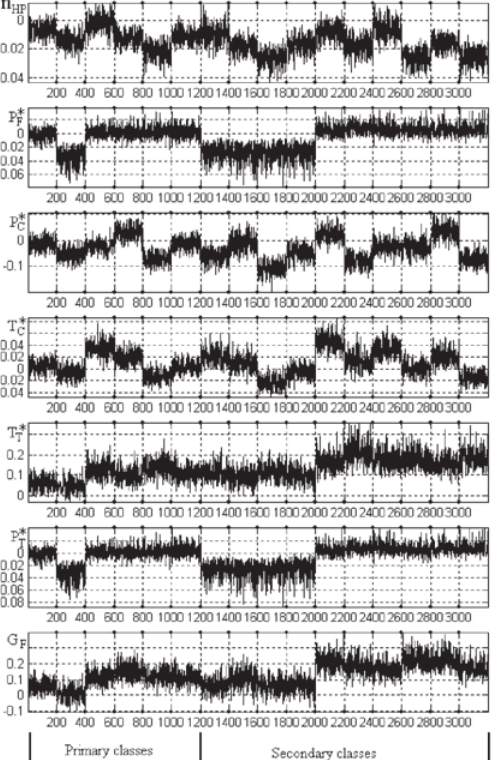
Fig. 2. The values of diagnostic deviations (Eq. (1)) in the test set for training a neural network to recognize 16 of the TC classes